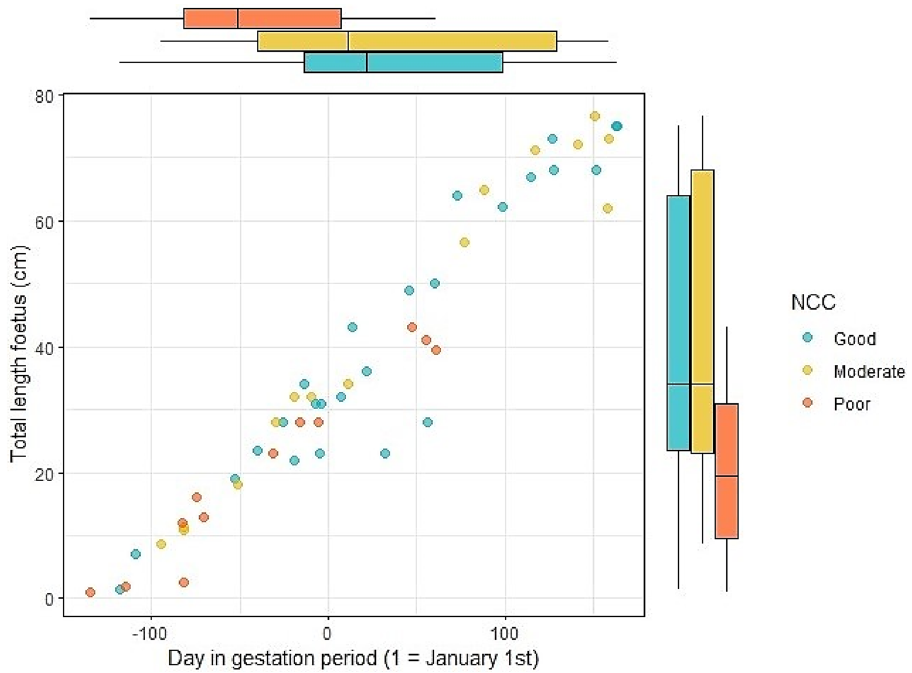
Figure 1. Foetus length as a function of nutritional condition of the mother. Combined scatterplot and boxplots of foetus length (y-axis) throughout the gestation period (x-axis). Coloured by nutritional condition category (NCC, based on blubber thickness, visceral fat and muscle mass assessed during post-mortem examination) of the mother (n = 50), with blue = good, yellow = moderate and orange = poor. One pregnant female carrying a twin was